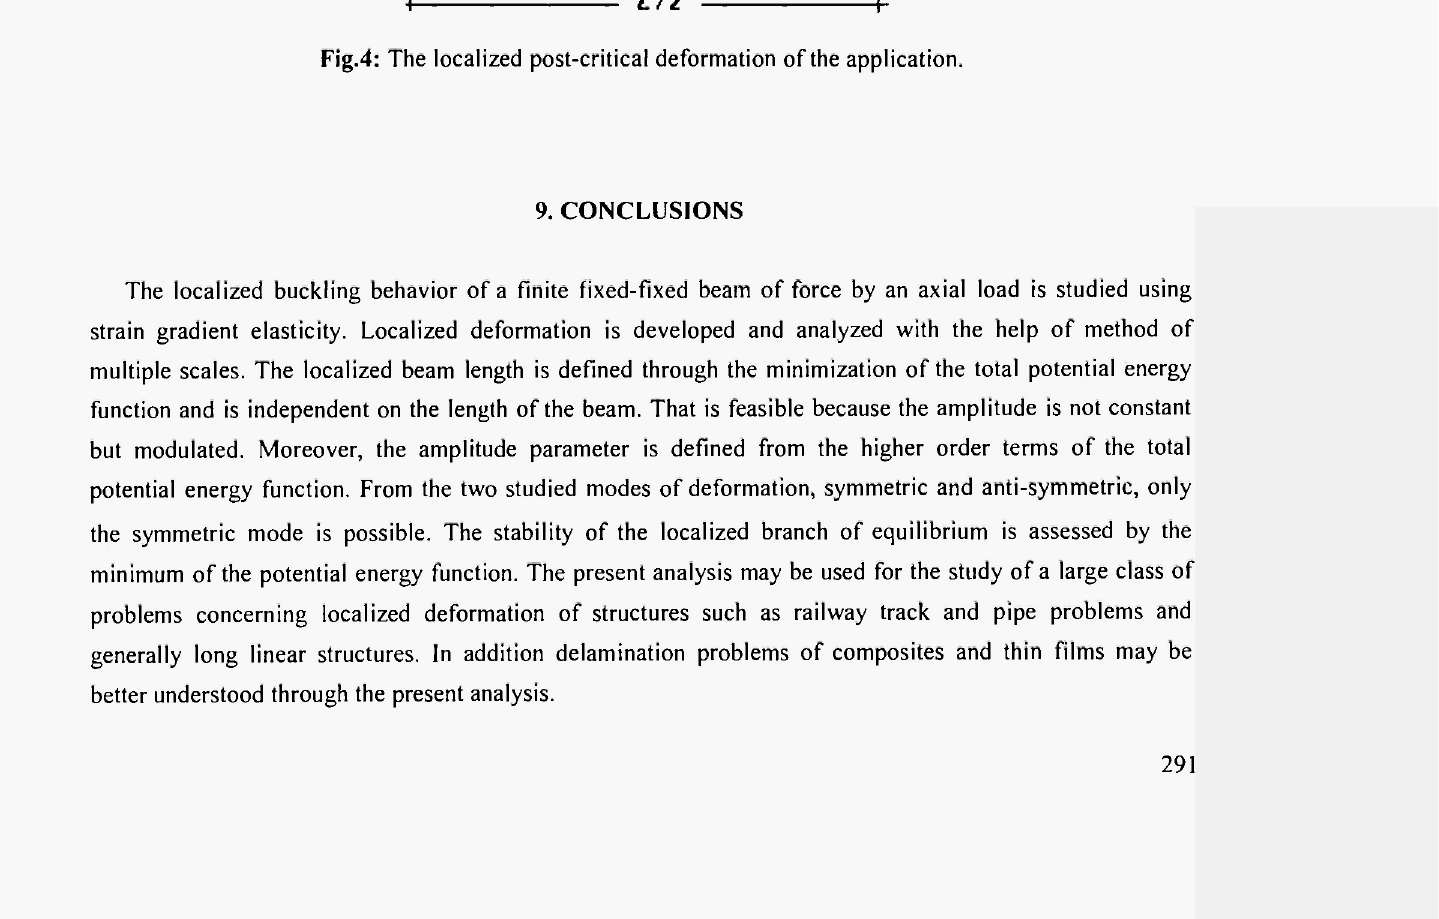
Fig.4: The localized post-critical deformation of the